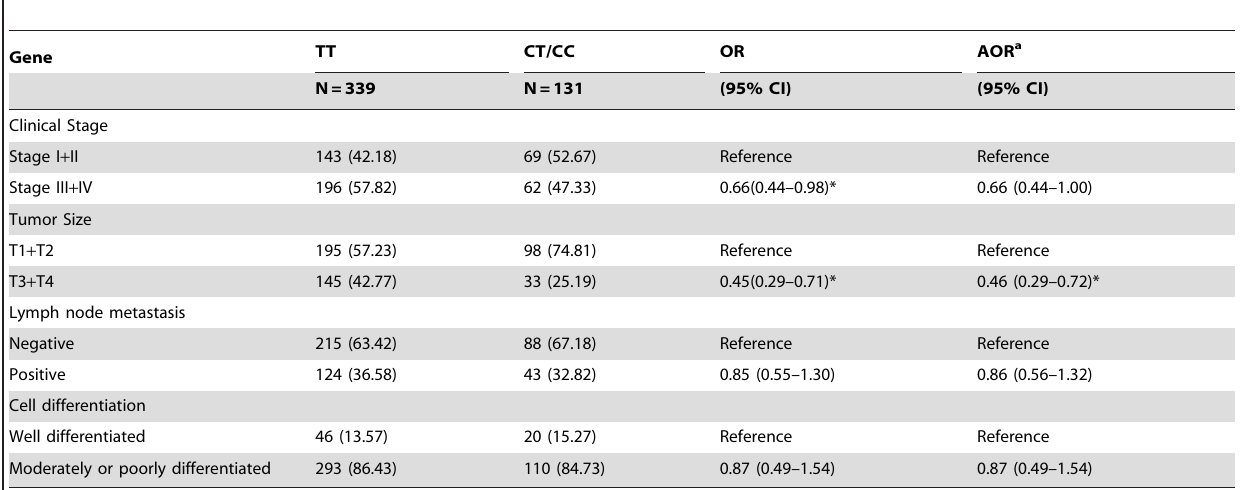
Table 4. Relationship of clinical status and miRNA499 genotypes in oral cancer